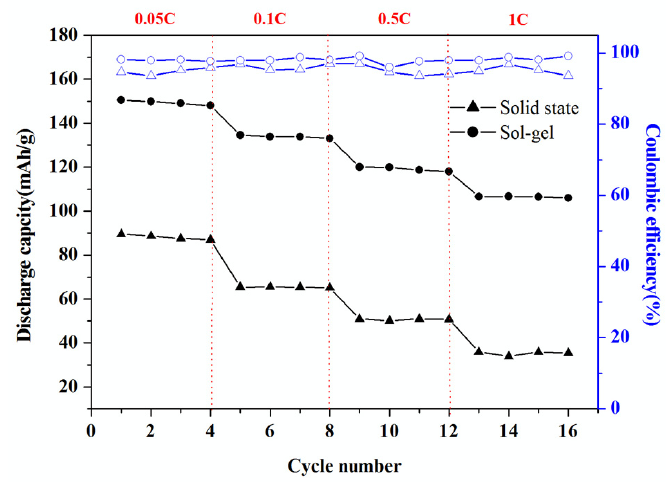
Figure 7. Rate capability of LiNi 0.5 Mn 0.5 O 2 pellets synthesized by the sol-gel method and solid-state method at different C rates.